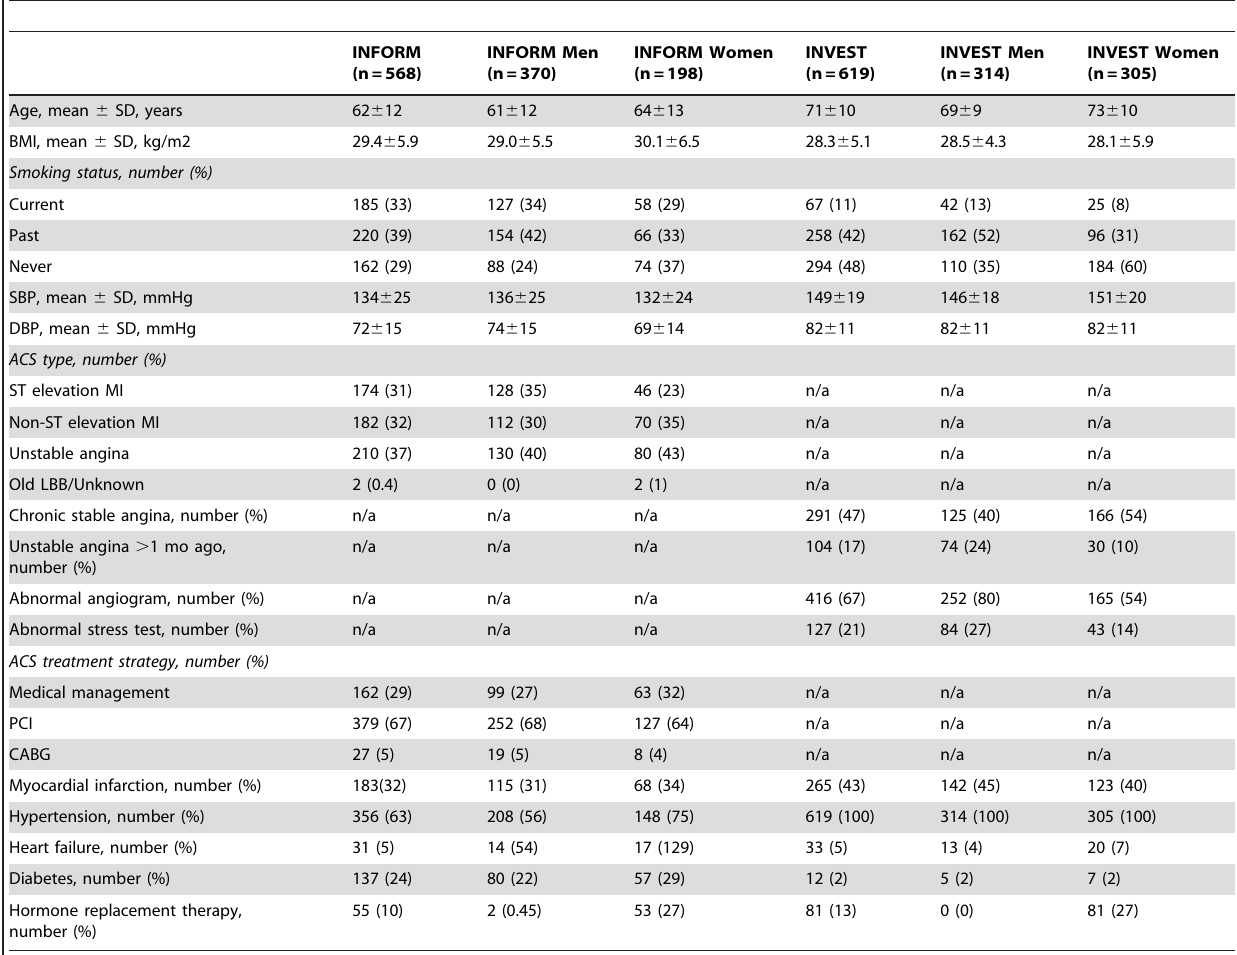
Table 2. Baseline Characteristics- INFORM and